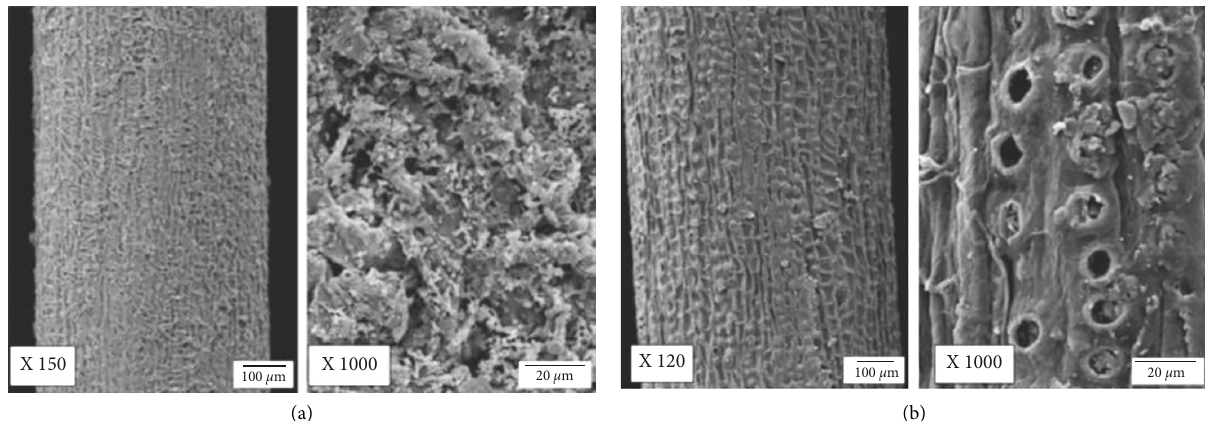
Figure 1: SEM images of date palm fibers: (a) immersed in Ca(OH) 2 solution for six months; (b) immersed in NaOH solution for six months at two magnifications [71]. Reproduced with permission from